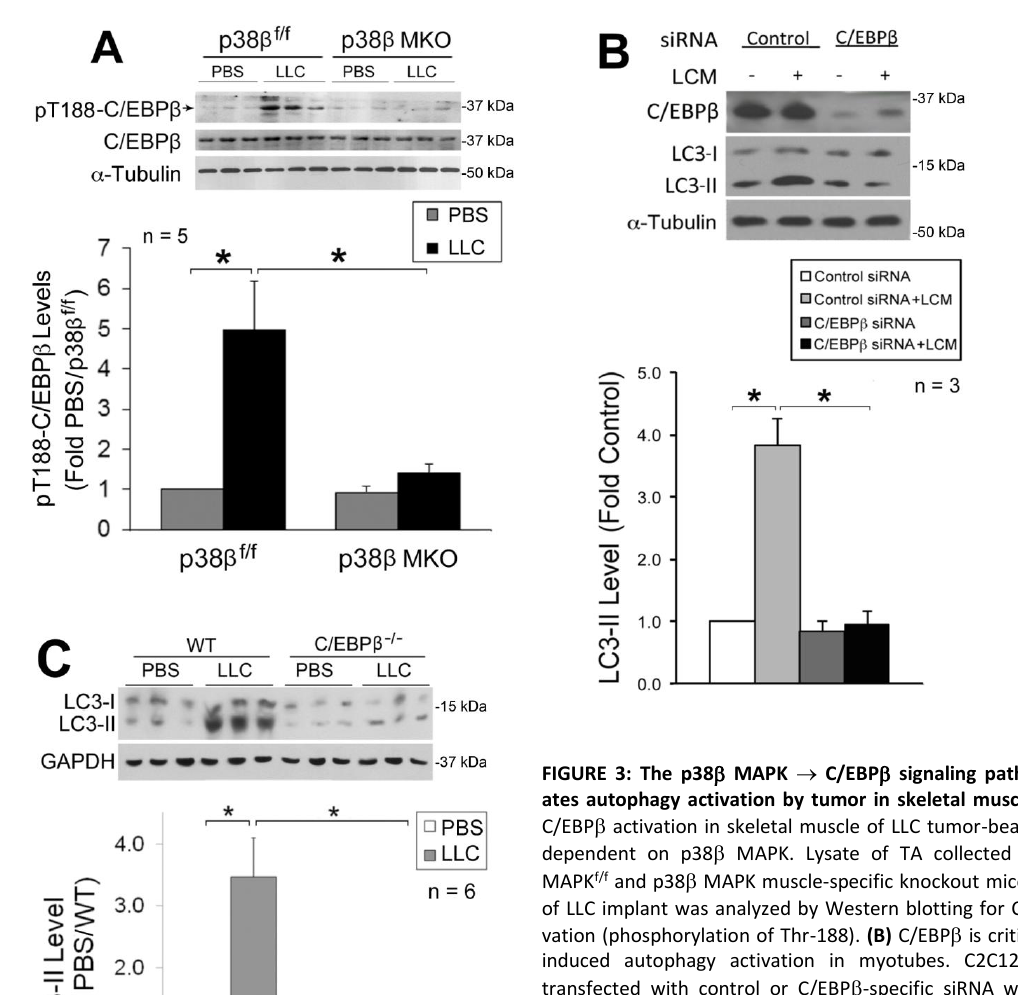
FIGURE 3: The p38  MAPK → C/EBP  signaling pathway